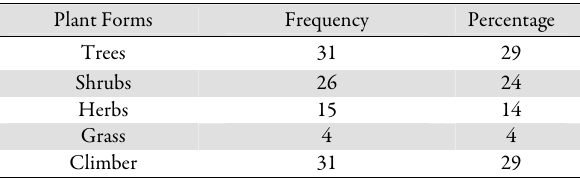
Table 3. The frequency and percentage of the plant life form of the study